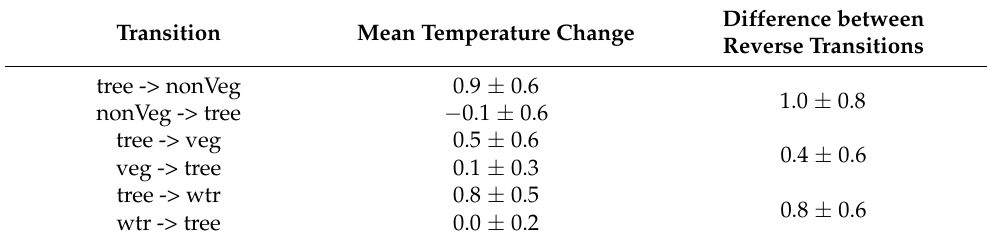
Table 5. Change in mean surface temperature (in ◦ C) for transition between tree and other land cover classes and the differences between mean changes for reverse transition classes. Values with ± indicate standard deviations of differences.